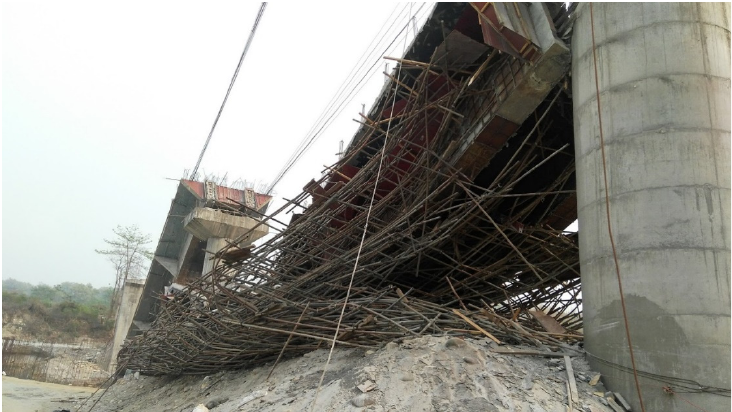
(Figure 23). However, near the fracture zone of the deck, the formworks were distorted due to bearing failure at bolted locations.